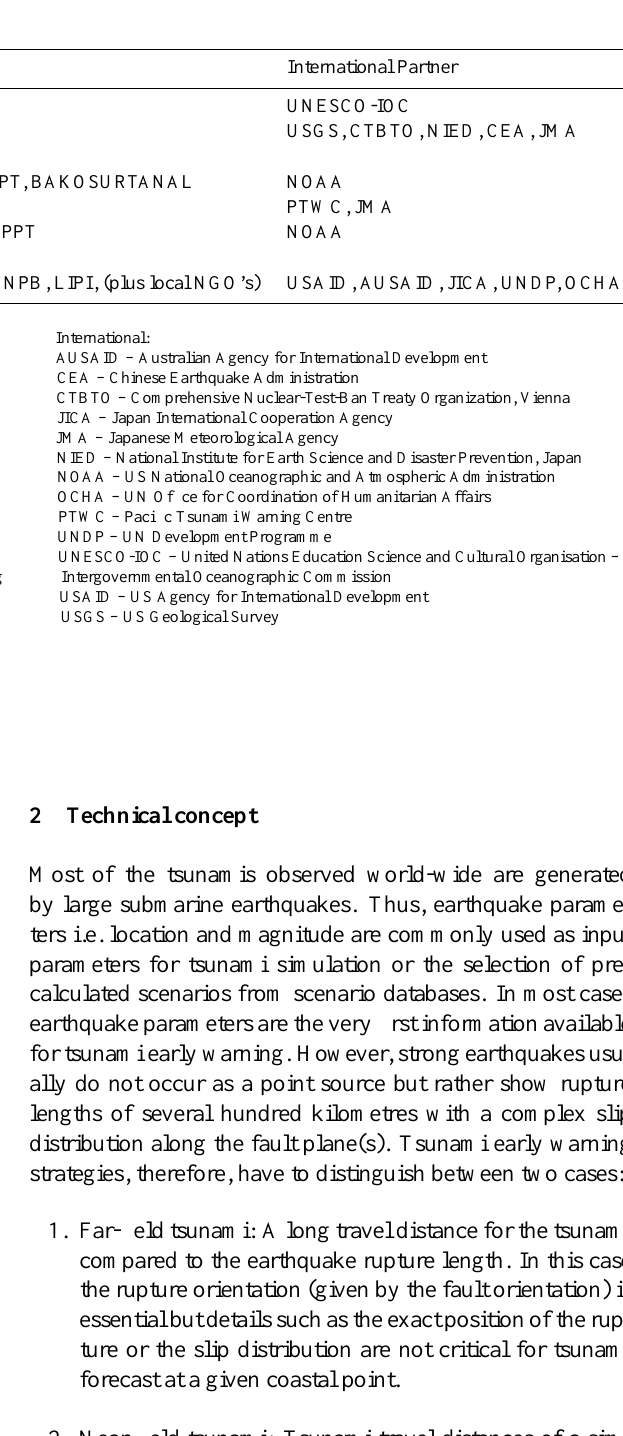
Table 1. Institutions and organisations who were involved in the development and installation of the tsunami early warning system in Indonesia.